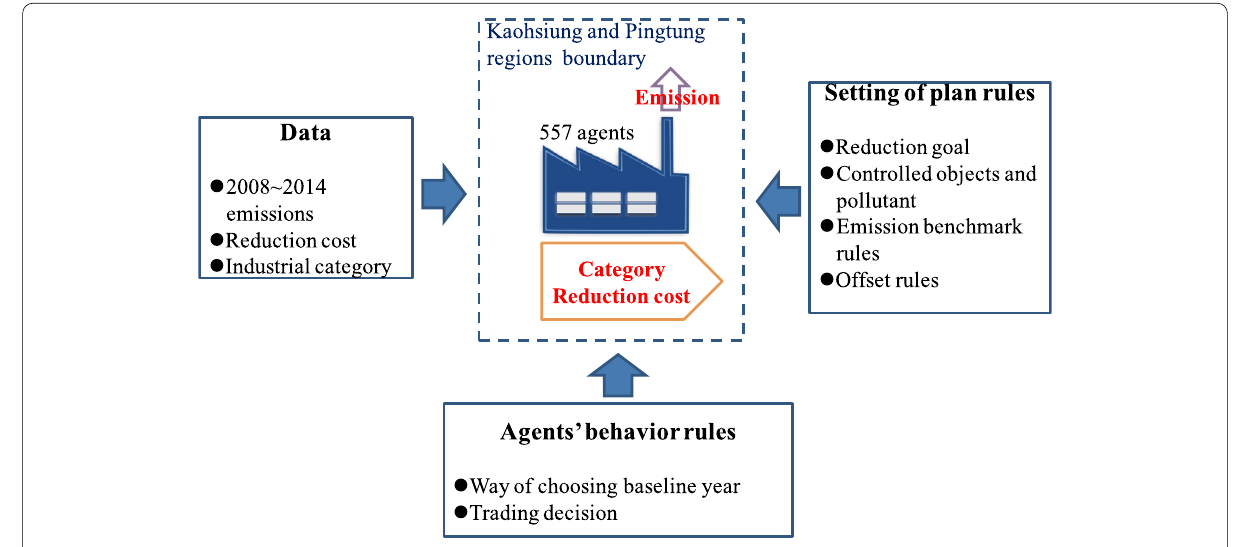
Fig. 1 Agent‑based model’s conceptual